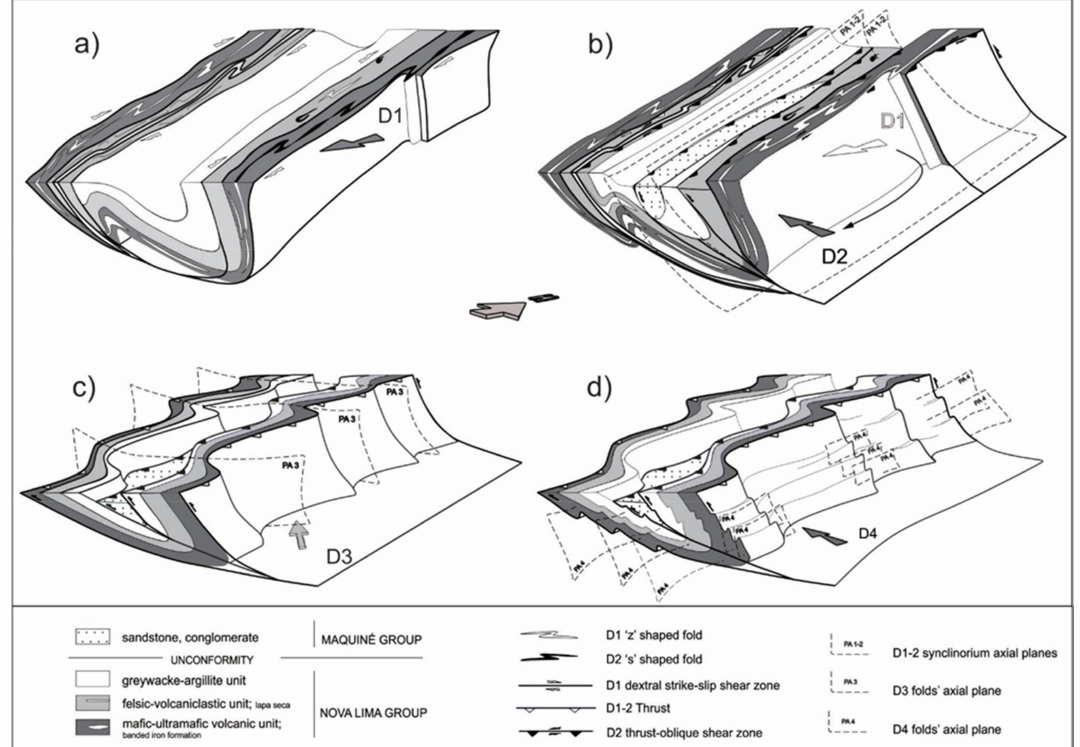
Figure 11. Schematic block diagrams showing the structural evolution of the Rio das Velhas greenstone belt in the northern QF region. ( a ) Archean D1 deformation phase; development of bedding parallel strike-slip shear zone, and ‘z’ folds in sti ff layers. ( b ) D2 phase of a progressive Archean deformation; reactivation of D1 structures and development of (new) thrust shear zones. ( c ) Paleoproterozoic D3 compressional phase; refolding of the structures generated in D1–D2. ( d ) Neoproterozoic D4 compressional phase; development of N–S trending open folds and related cleavage in the Nova Lima rocks. See text for further